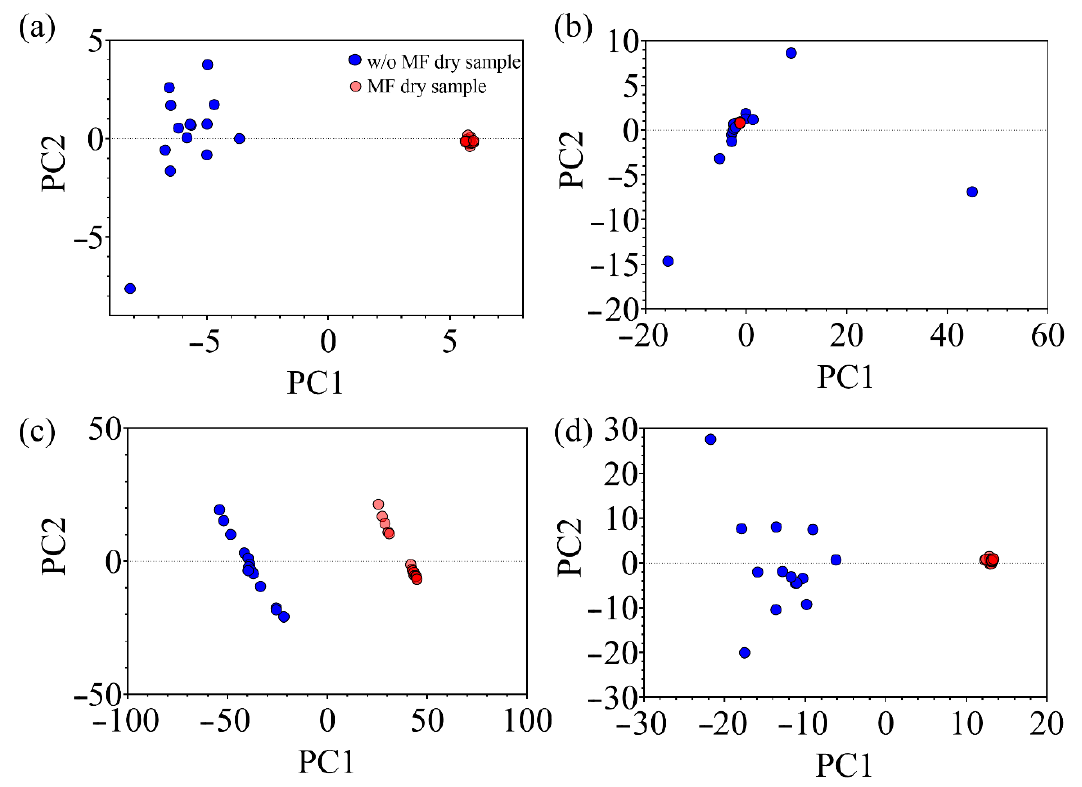
Figure 6. ( a )PCA score plot of ketoprofen in the range 4000–650 cm − 1 ( b ), and in the range 1675–1475 cm − 1 ( c ). PCA score plot of KiOil in the range 4000–650 cm − 1 ( d ), and in the range 1800–650 cm − 1 .